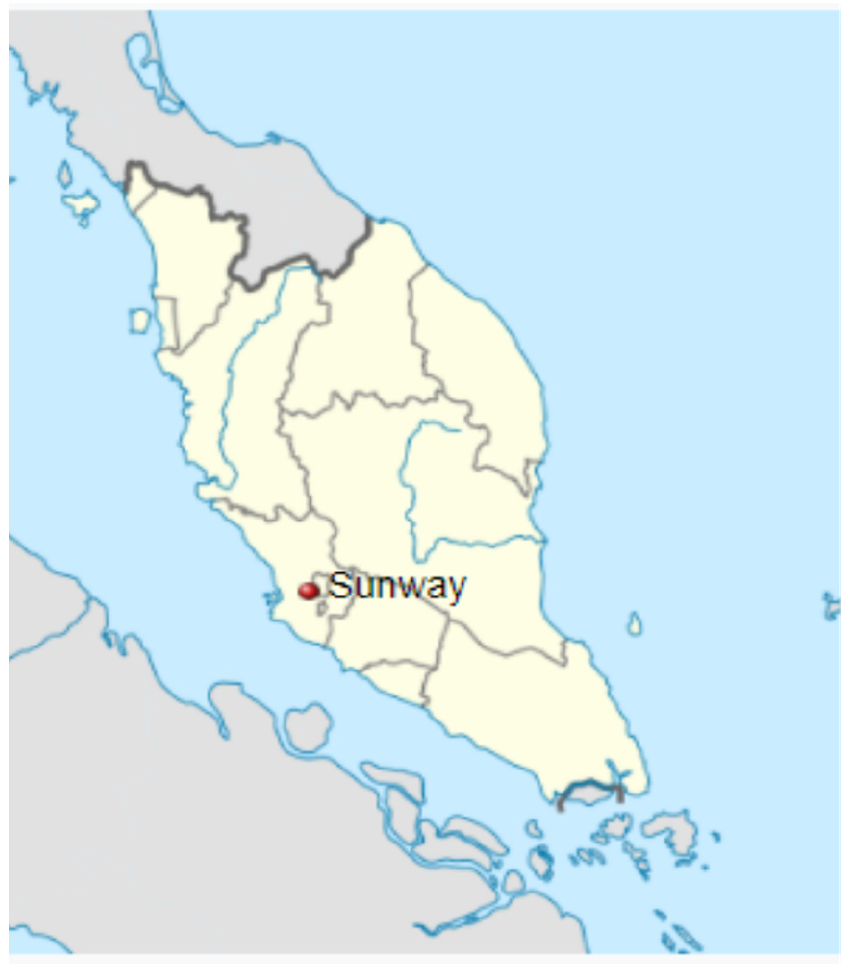
Figure 1. Location of Bandar Sunway. Source: [53].